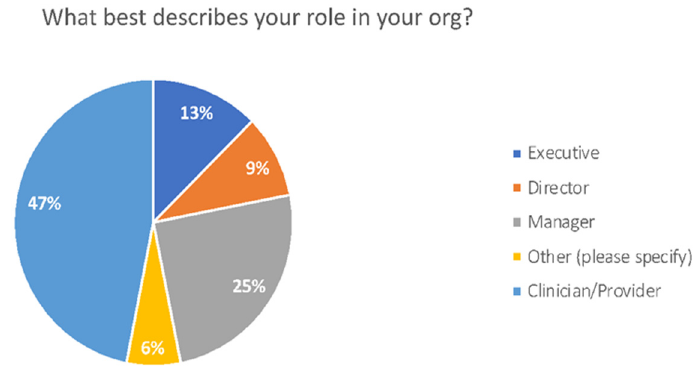
Figure 2. Role of providers